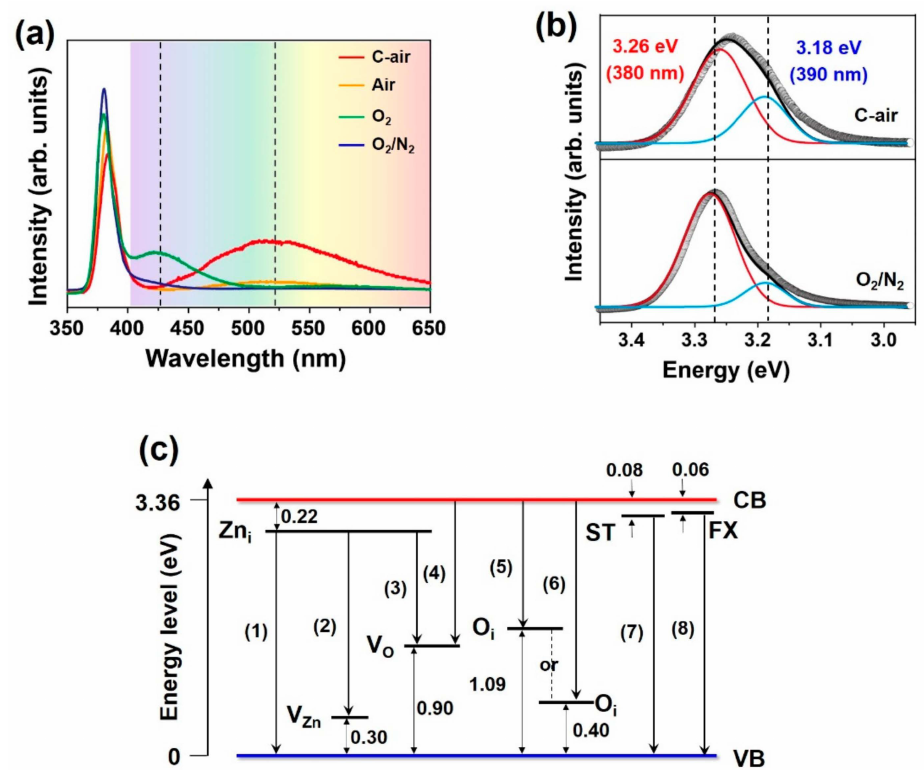
Figure 6. ( a , b ) Room-temperature PL spectra of synthesized ZnO nanomaterials using di ff erent gases. ( c ) Energy level diagram showing some of the principal defect levels in ZnO